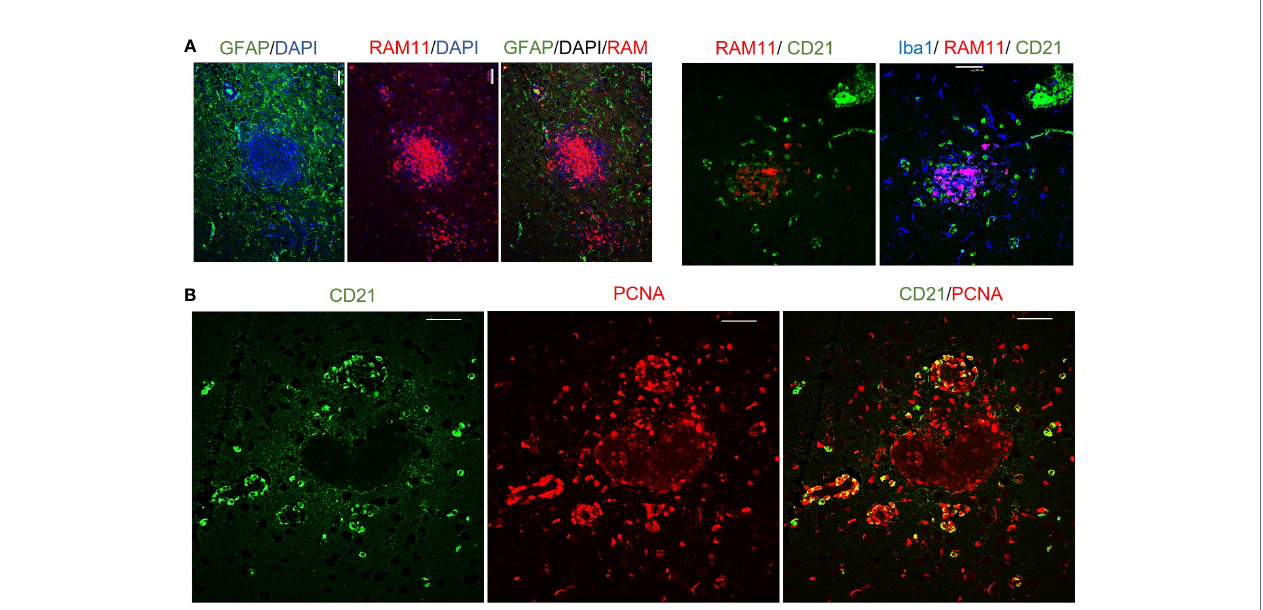
FIGURE 4 | Immuno fl uorescence double staining to determine the cellular makeup of cerebral aggregates in EBV infected rabbits. (A) Representative immuno fl uorescence staining of in fl amed brain section with GFAP (green), RAM11 (red), and DAPI (blue). Scale bar=20 m m. Location of B cells (green) in relation to macrophages (red) and microglia (blue) were identi fi ed by staining for CD21, RAM11 and Iba1, respectively. Scale bar=40 m m. (B) Double positive CD21 (green) and PCNA (red) depict proliferating B lymphocytes in cerebral aggregates. Scale bar=40 m